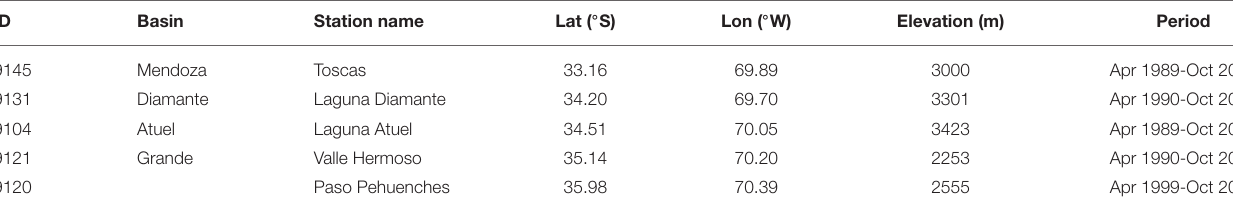
TABLE 2 | Main characteristics of the snowpack stations used in this study.